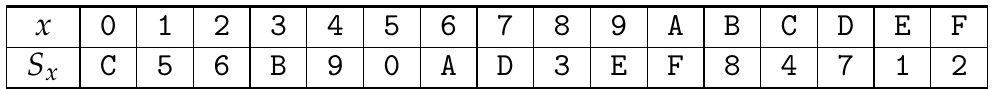
Table 1. PRESENT S-box.